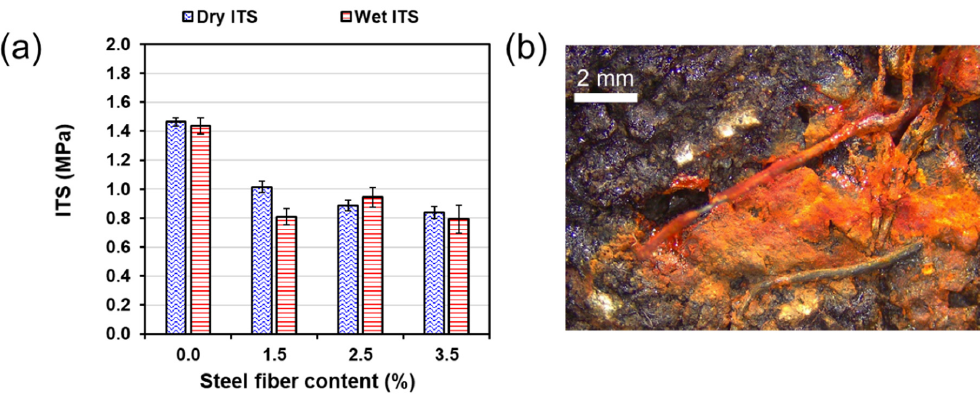
Figure 11. ( a ) Effect of steel fiber on indirect tensile strength, and ( b ) corrosion of metal fibers after soaking. The fibers were not coated with bitumen.